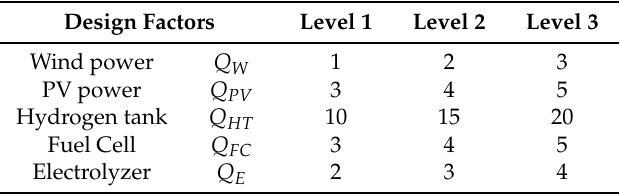
Table 2. The design factors and their corresponding